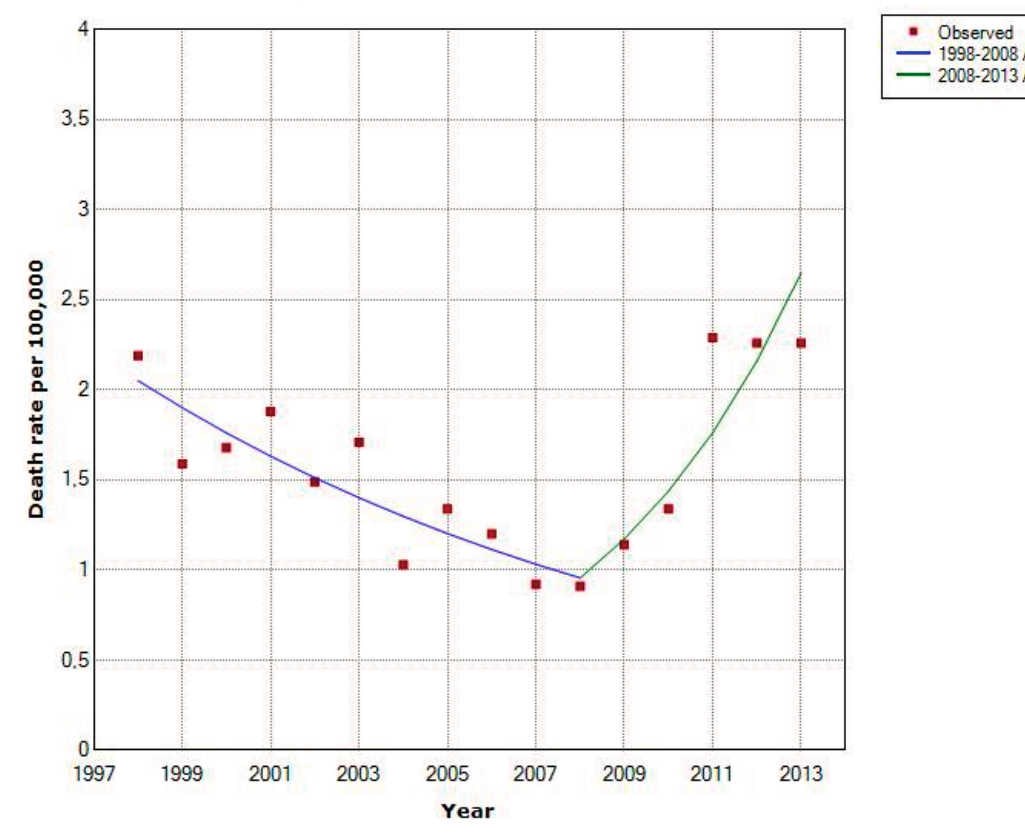
Figure 2. Joinpoint regression analysis of age-standardized death rates per 100,000 inhabitants according to the Swedish Causes of Death Register for both genders combined, all ages during 1998–2013 diagnosed with D43 = tumour of unknown type in the brain or CNS [29]. ^ Indicates statistically significant